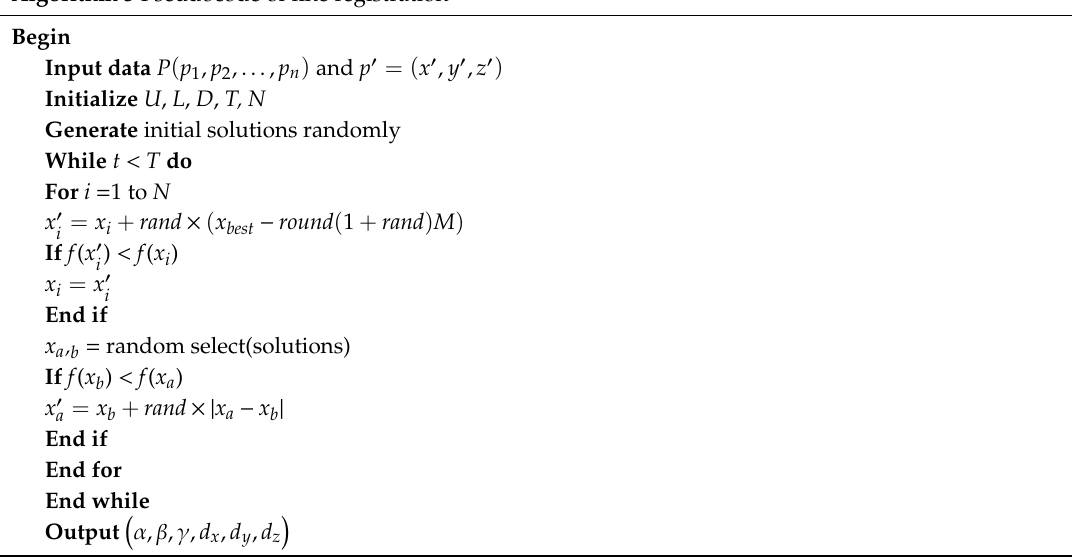
Algorithm 3 is the pseudocode of fine registration. Algorithm 3 Pseudocode of fine